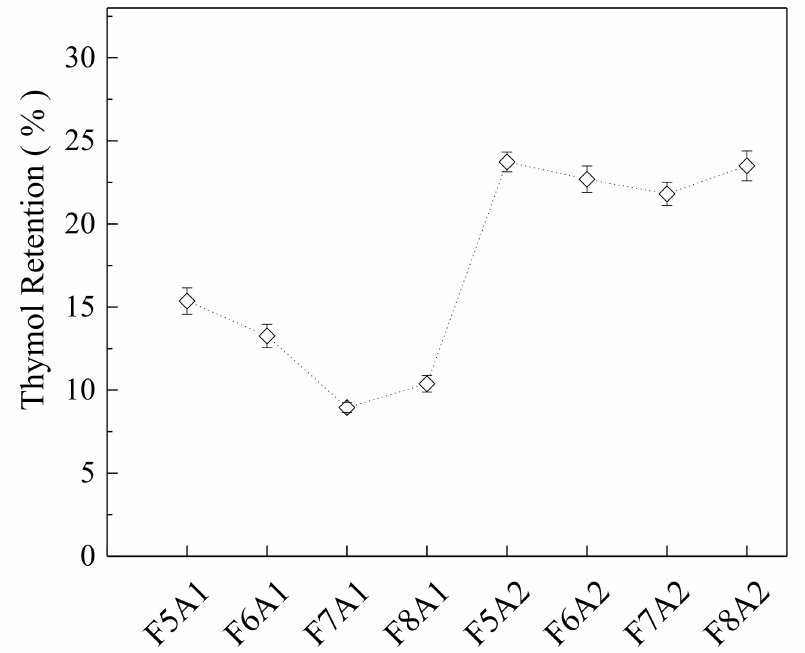
Figure 2. Retention of thymol in the spray dried product. Percentage relative to the initial concentration of thymol in essential oil.